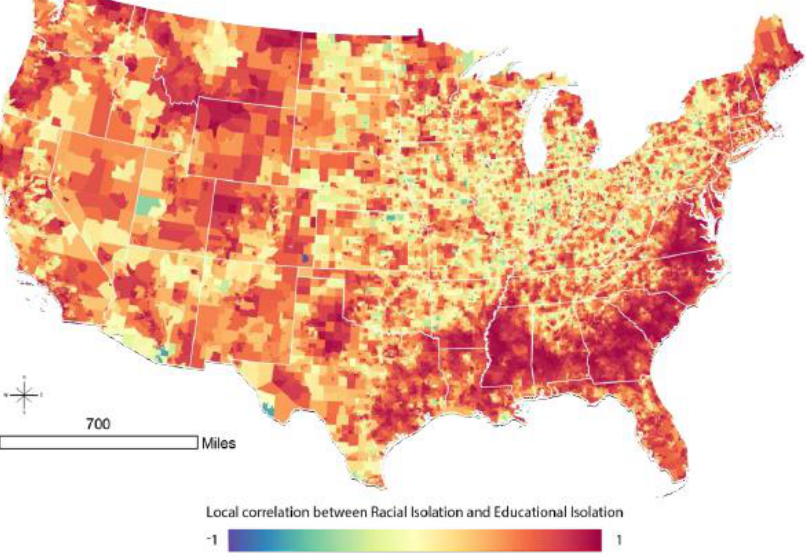
Figure 4. Local correlation between racial isolation and educational isolation.